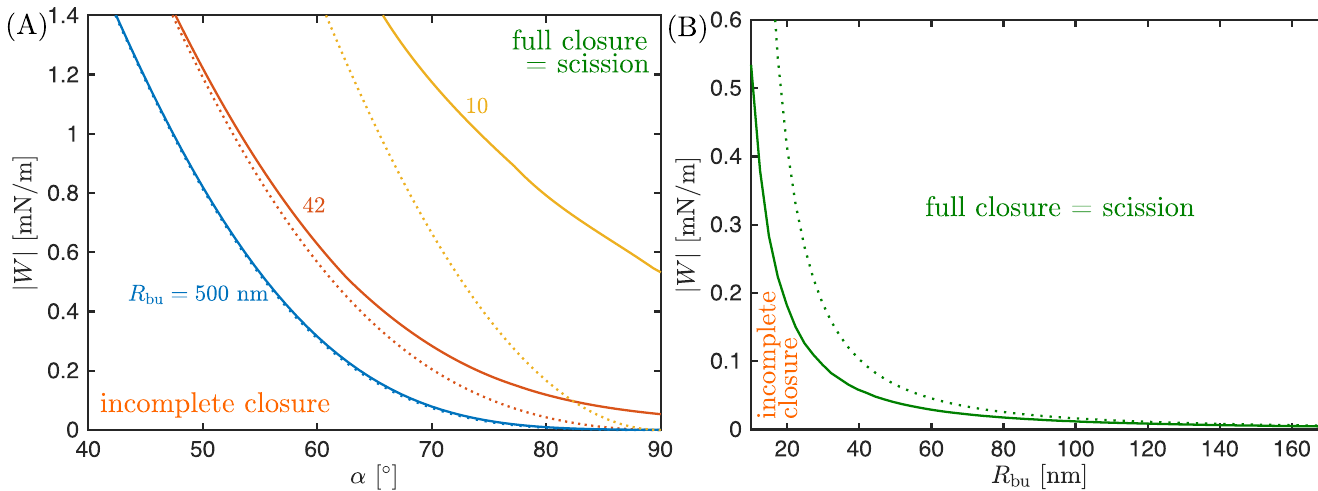
Fig 6. Regimes of incomplete and full closure for cone-shaped assemblies. (A) Critical value | W | sc of the adhesive strength | W | for which the neck radius becomes R ne = 3 nm, leading to neck closure and scission, as a function of the cone apex angle α , for bud radii R bu = 500, 42 and 10 nm. For fixed | W |, flattening of the cone (i.e. increasing α towards 90˚) leads to scission, except for low | W | for which not even full flattening of the cone ( α = 90˚) can achieve scission. This minimal value of the adhesive strength necessary for scission at full flattening is shown in (B), as a function of the bud radius R bu . In both (a) and (b), solid lines correspond to numerical results, while dotted lines correspond to the analytical approximations given by Eq 12 in (A) and by Eq 13 in (B).